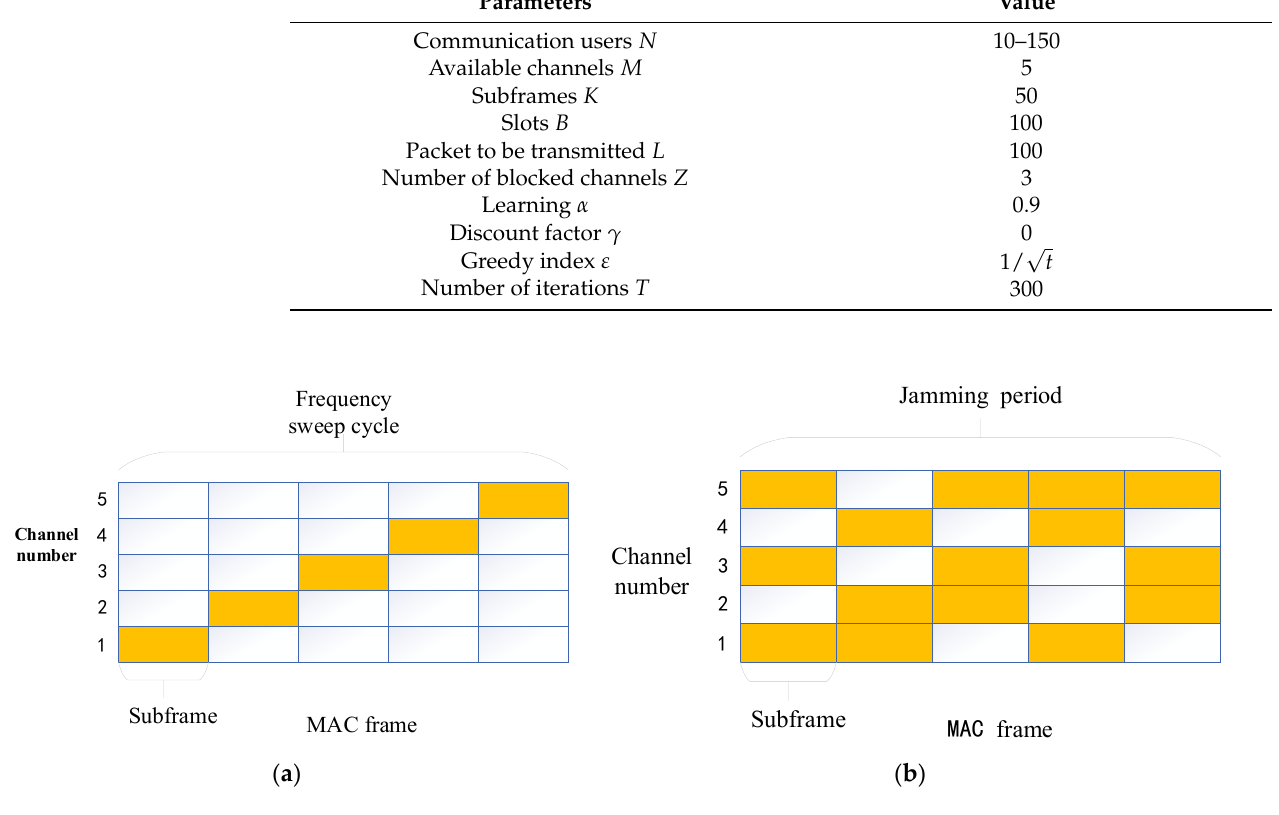
Figure 2. ( a ) Linear frequency sweep jamming. ( b ) Multi-channel intelligent blocking jamming.